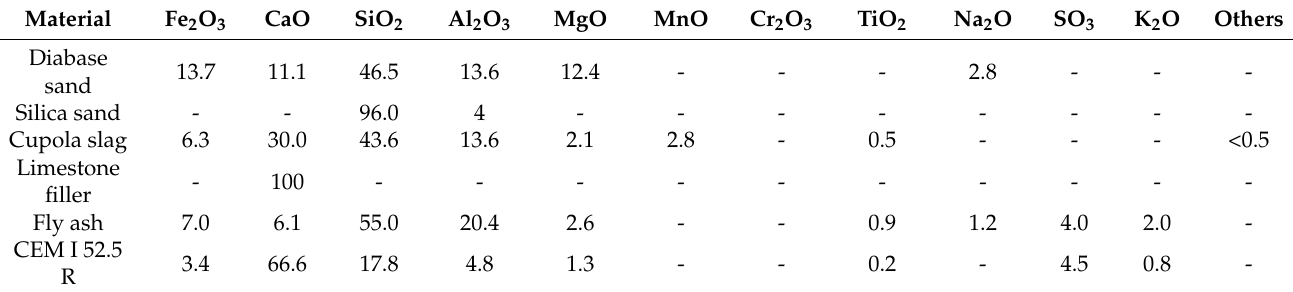
Table 2. Composition in oxides of the materials used (%